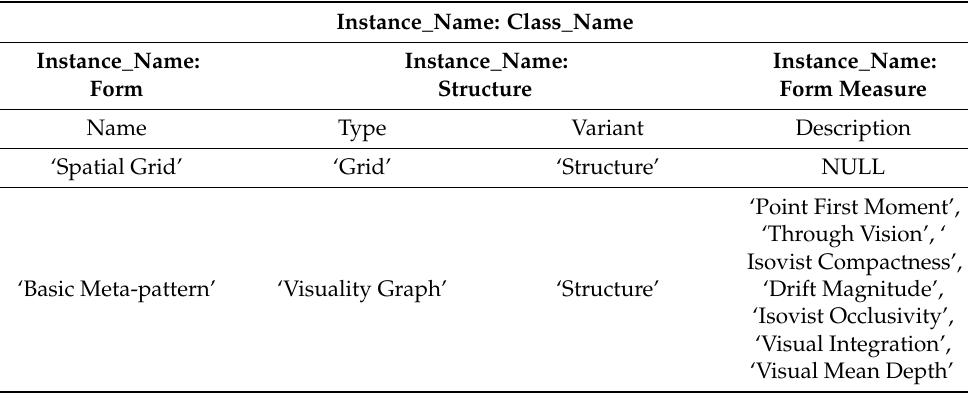
Table 5. Forms and structures for basic